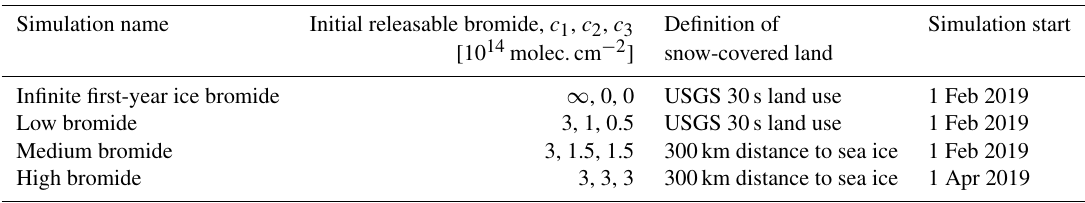
Table 1. Overview of the four simulations. Initial releasable bromide; see Eq.